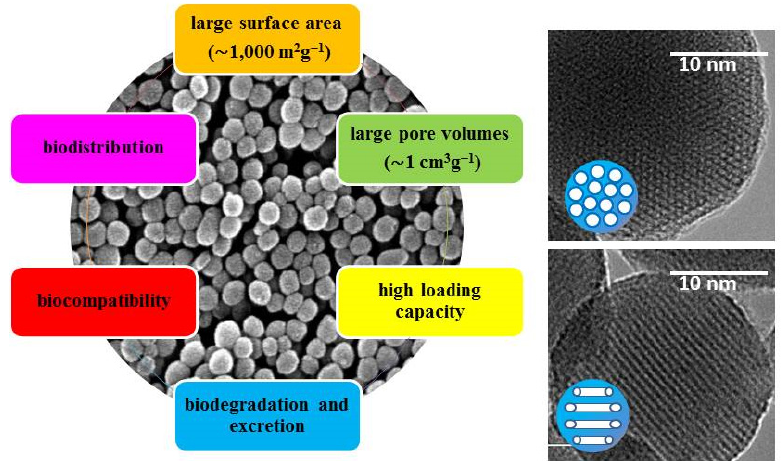
Figure 2. Left : Main characteristics of MSNs. Right : transmission electron microscopy (TEM) images of 2D-hexagonal MCM-41 type mesoporous silica nanoparticles (MSNs) taken with the electron beam parallel ( up ) and perpendicular ( down ) to the mesoporous